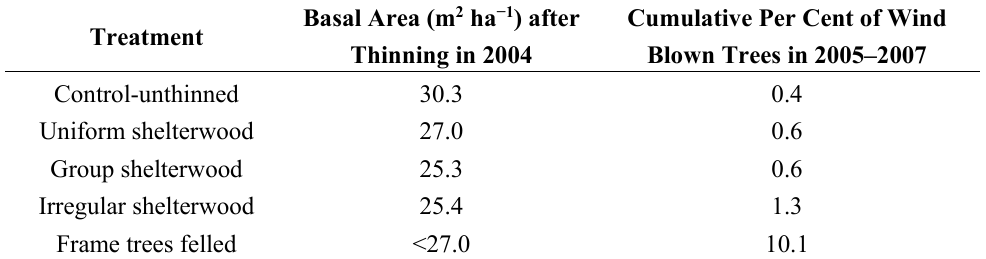
Figure 1. Distribution (density) of calculated wind speeds causing tree failure in the range 10–18 m s −1 for the experimental stand in Clocaenog Forest for the unthinned (original) stand and after the application of four different simulated thinning scenarios (see text for details). Table 4. Effect of thinning to implement different silvicultural approaches upon subsequent wind damage in the Clocaenog research area (after Haufe,